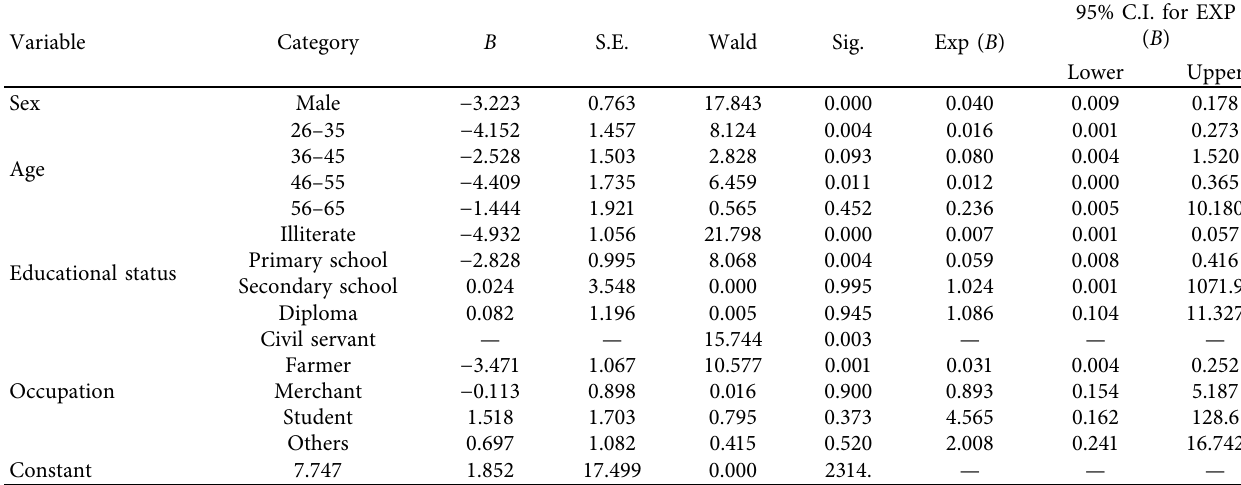
Table 7: Multivariable binary logistic regression analysis of knowledgeable factors for the elimination of onchocerciasis from Gesha town,